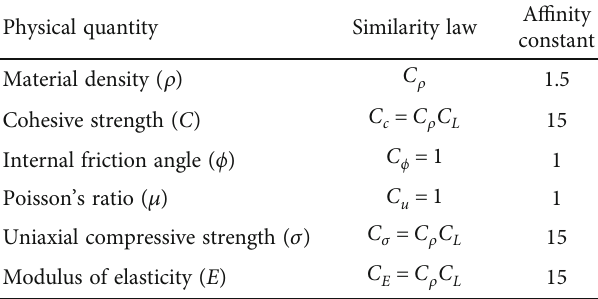
Table 1: Similitude laws and constants of the model.